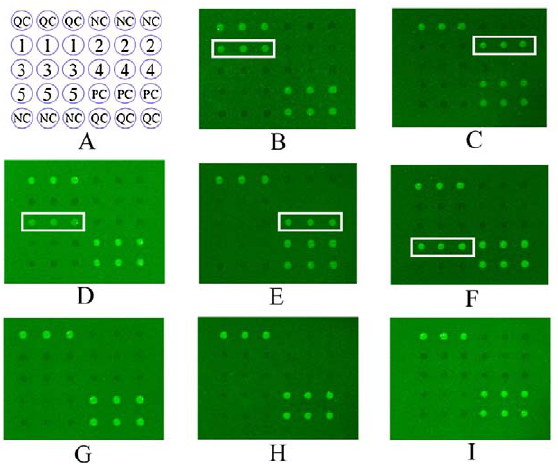
Figure 3. Protein microarrays probed with human sera with various food-borne helminthiases. Disposition of microarray (A), the semi-purified antigens of the parasites recognized by the sera from patients infected with C. cellulosae (B), A. cantonensis (C), P. westermani (D), T. spiralis (E), Spirometra plerocercoids (F), healthy adult (G), A. lumbricoides (H) and S. japonicum (I) with the method of protein microarrays, respectively. On panel A, QC=quality control; PC=positive control of arrays; NC=negative control of arrays; Spot 1 to 5=the semi- purified antigens with the molecular weight of 95, 98, 35, 55 and 90 kDa from C. cellulosae , A. cantonensis , P. westermani , T. spiralis and Spirometra plerocercoids, respectively.